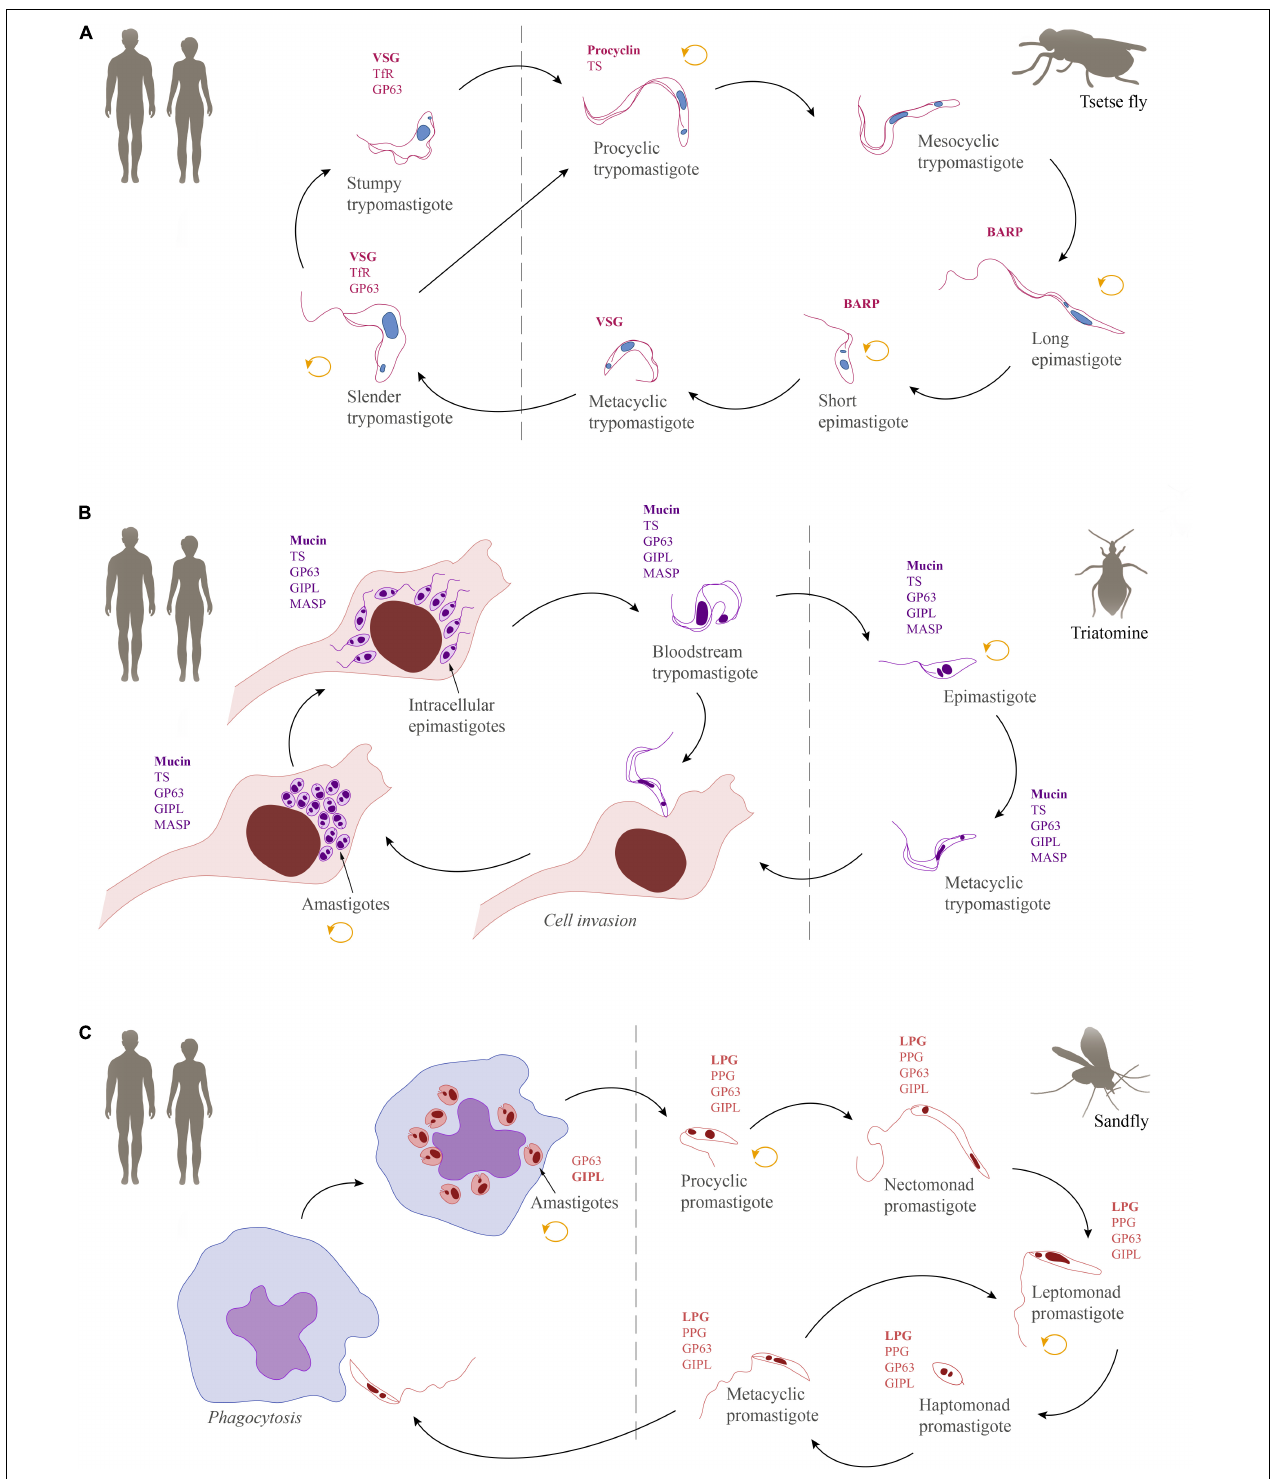
FIGURE 4 | Schematic overview of the life cycles of human-infective trypanosomatids together with their most abundant GPI-anchored molecules. (A) Trypanosoma brucei , (B) Trypanosoma cruzi , and (C) Leishmania . The replicative stages are indicated by a circular arrow (orange). GPI-anchored surface molecules: variant surface glycoprotein (VSG), transferrin receptor (TfR), GP63, procyclin, trans -sialidase (TS), brucei alanine rich protein (BARP), mucin, glycoinositolphospholipid (GIPL), mucin-associated surface protein (MASP), lipophosphoglycan (LPG), proteophosphoglycan (PPG).